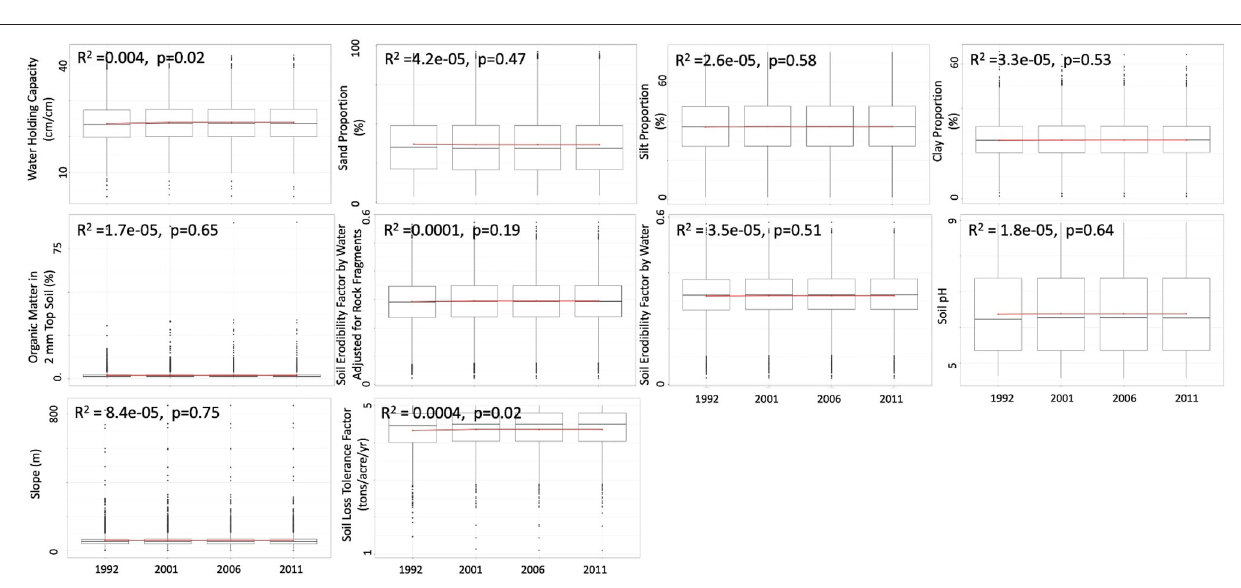
We have adopted data synthesized from literature (Yun and Gramig, 2019) and quantified to estimate the impacts of climate change and various soil factors on yields of four major